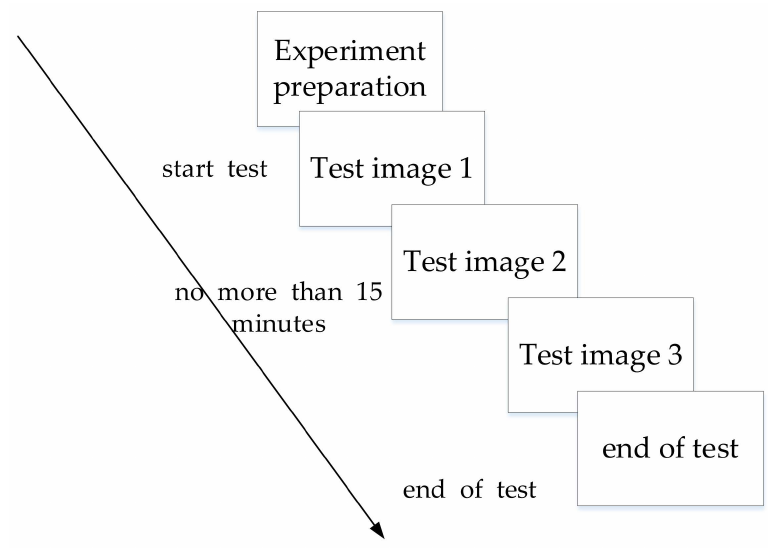
Figure 6. Hazard perception test flow